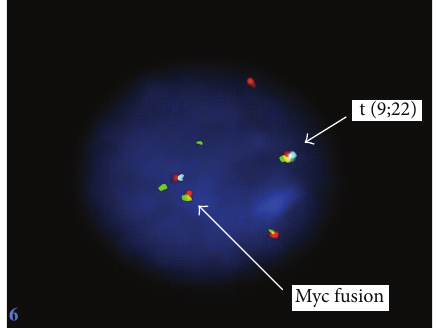
Figure 6: Interphase FISH analysis showing a t(9;22) and MYC gene